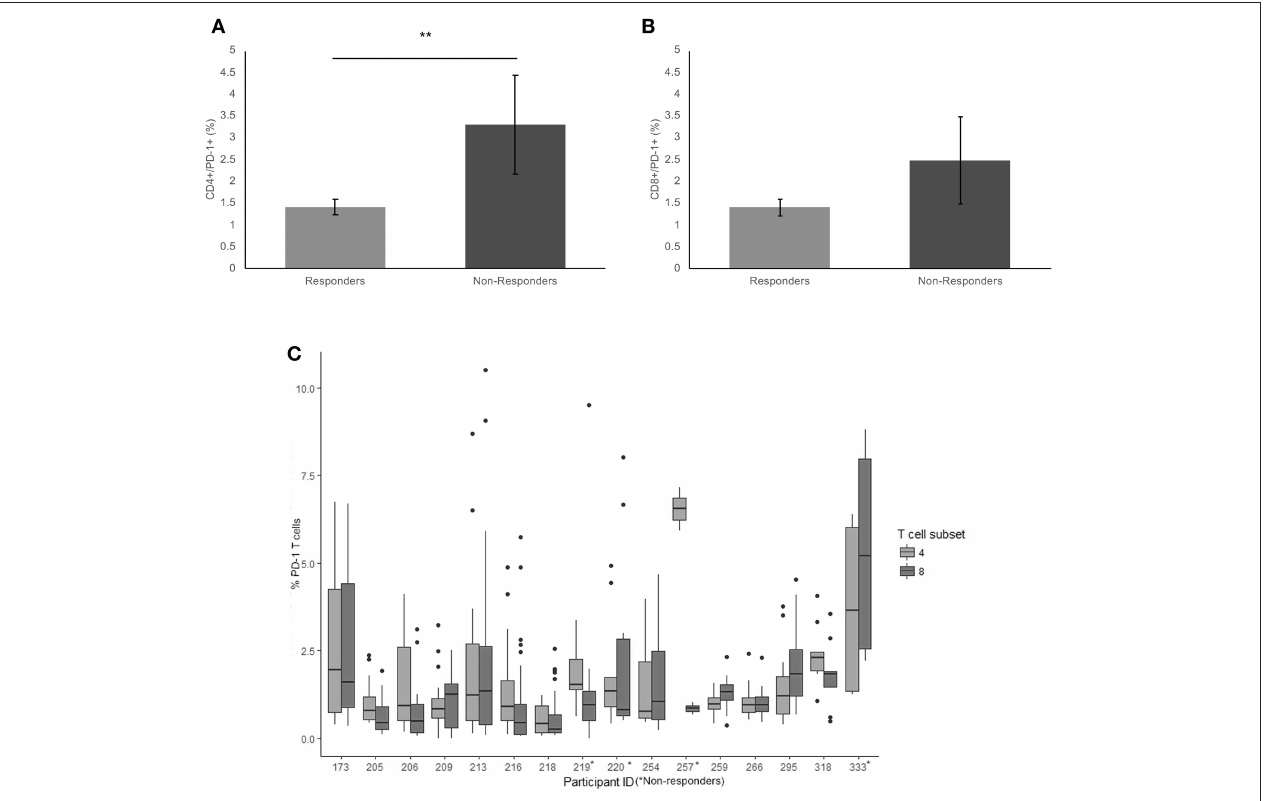
FIGURE 1 | Frequency of PD-1 expressionon CD4 + and CD8 + T cells. (A) The mean percentage of CD4 + T cells expressing PD-1 in non-responders responders to pembrolizumab (B) The mean percentage of CD8 + T cells expressing PD-1 in non-responders responders to pembrolizumab (C) Boxplot of mean frequency of PD-1 on CD4 + and CD8 + T cells per patient per cycle. ** p < 0.01.